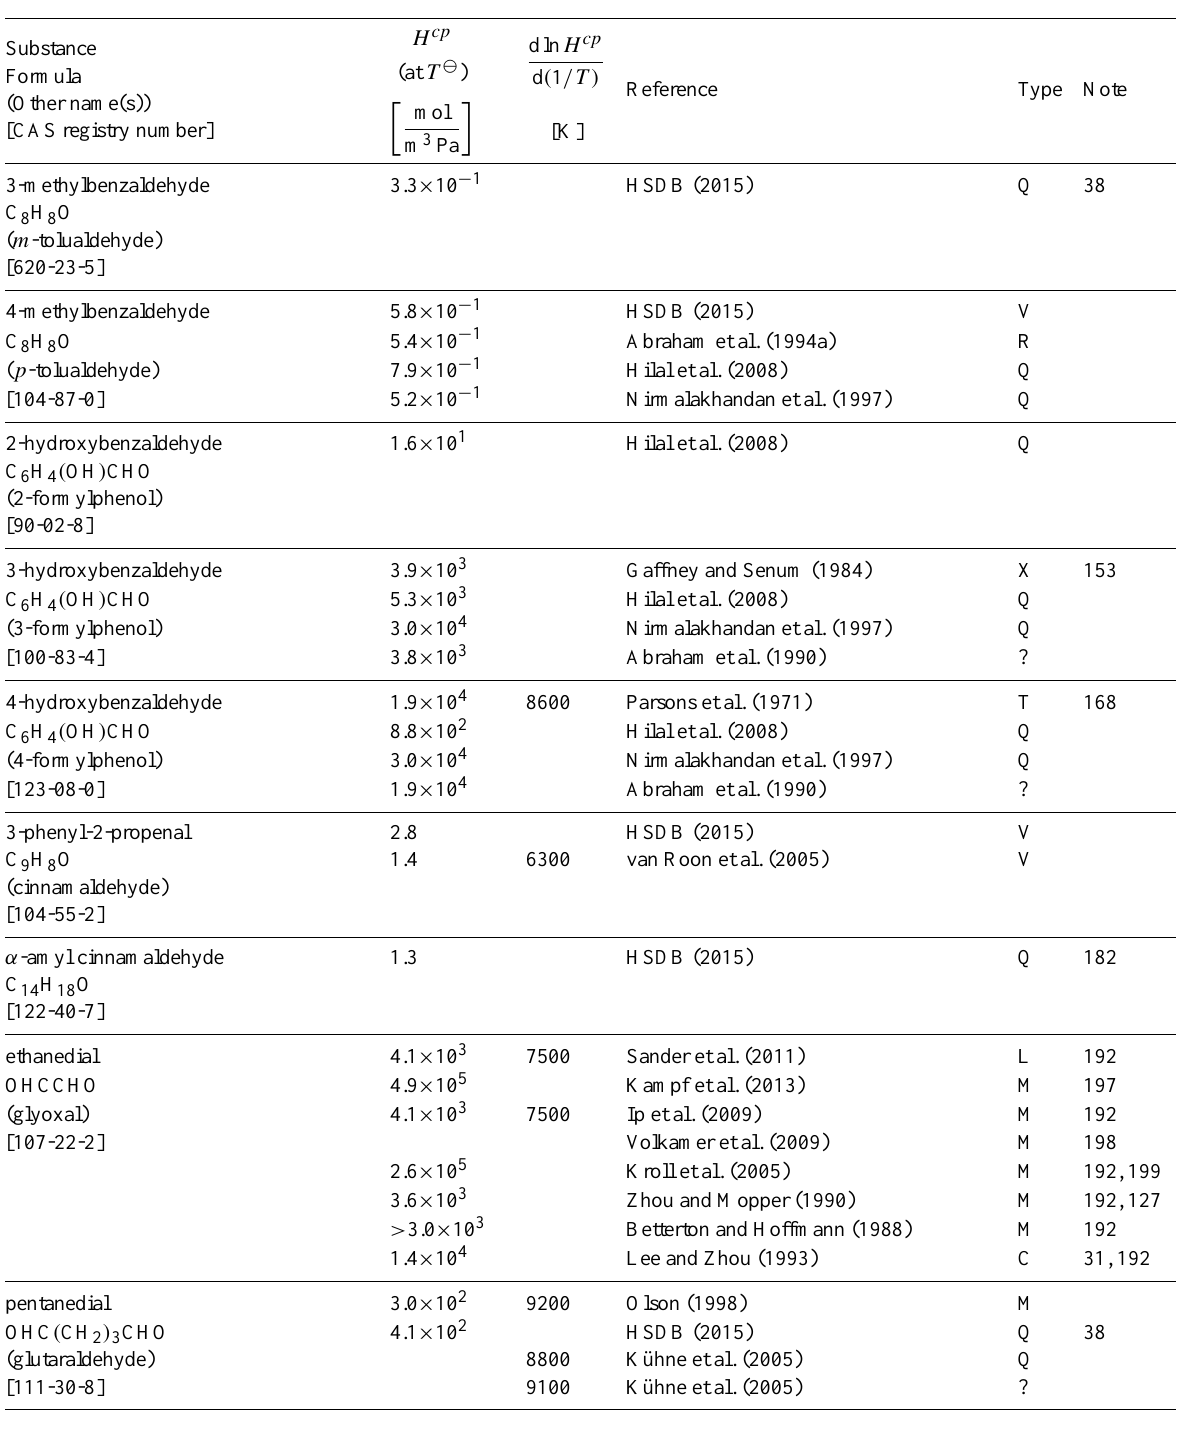
Table 6: Henry’s law constants for water as solvent